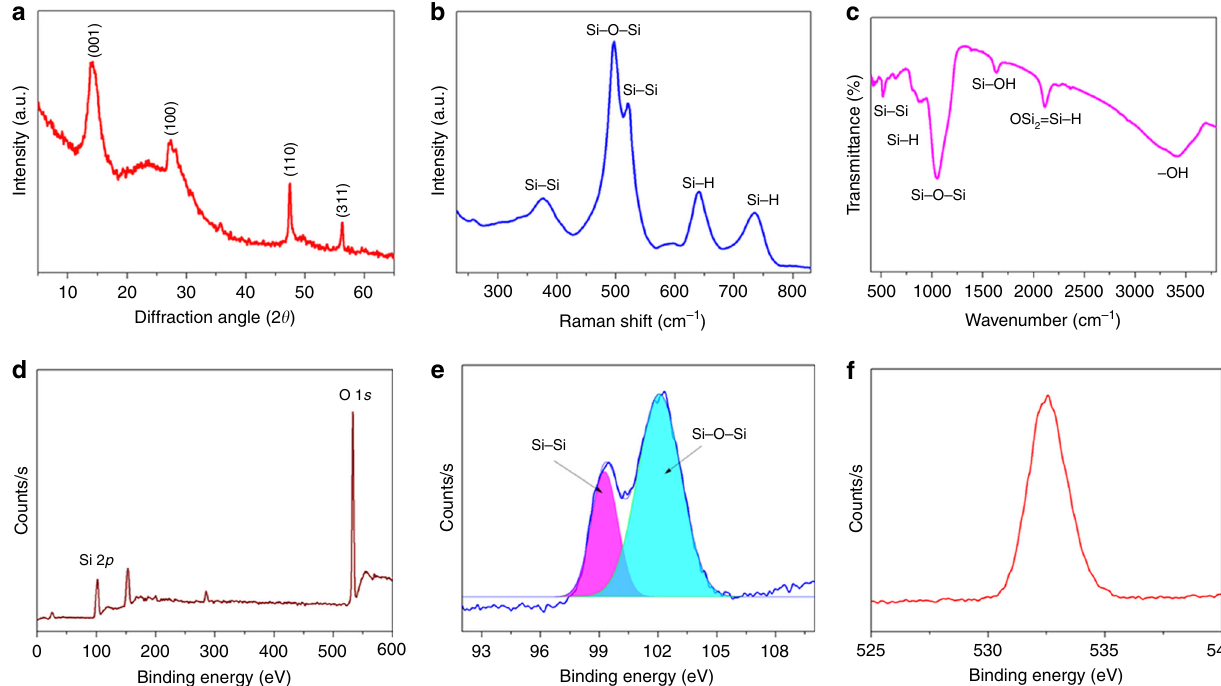
Fig. 2 Physicochemical characterization of siloxene sheets. a X-ray diffraction spectrum of siloxene sheets, b laser Raman spectrum of siloxene sheets, c Fourier transformed infrared spectrum of siloxene sheets, d XPS survey spectrum of siloxene sheets, e Si 2 p , and f O 1 s core-level spectra of siloxene